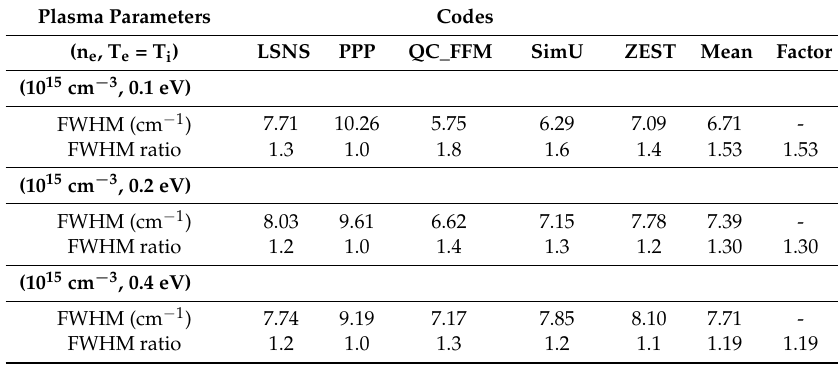
Figure 7. The H- β line FWHM versus the electron temperature as deduced from the profiles calculated by the codes. ( a ) Lower electron density (n e = 10 15 cm − 3 ); ( b ) Higher electron density (n e = 10 16 cm − 3 ). Table 1. FWHM in units of cm − 1 as deduced from the profiles calculated by each of the five codes LSNS, PPP, C_FFM, SimU, and ZEST. The FWHM ratio stands for the ratio of the highest value of the FWHM to each FWHM. The highest value corresponds to the PPP calculations except for n e = 10 16 cm − 3 and T e = 0.4 eV where it corresponds to the LSNS